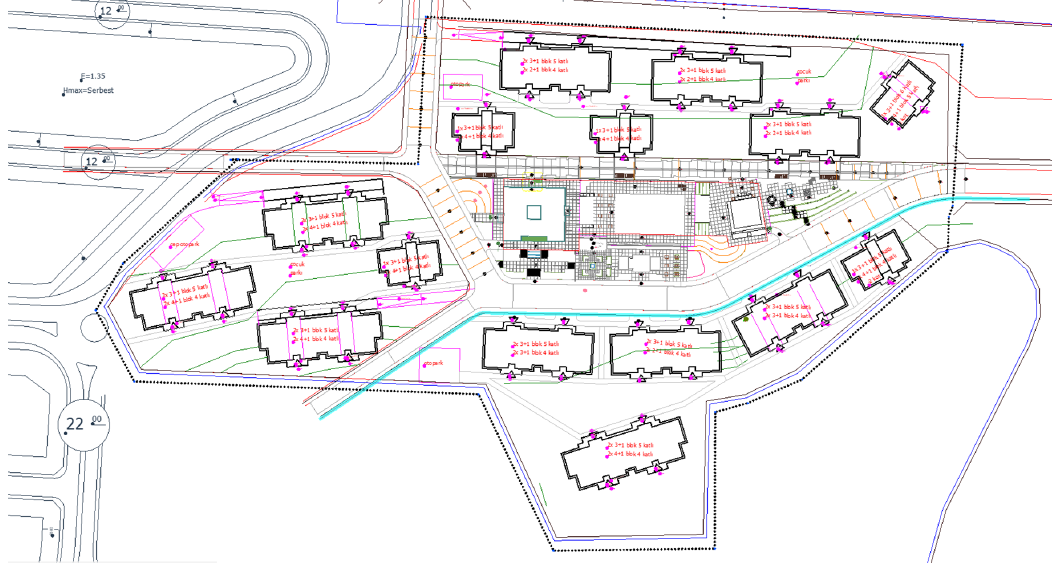
Figure 8. A part of the project site plan with georeferencing information in two dimensions (2D)